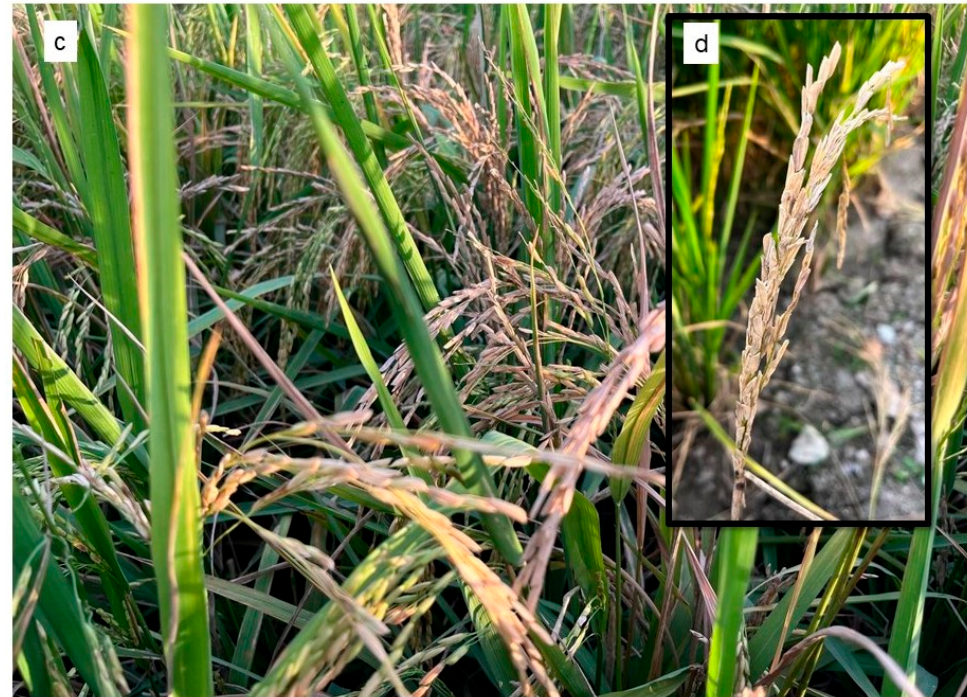
Figure 2. Excessive use of biocides and chemical fertilizers resulted in the severe outbreaks of various rice diseases in Selangor, Malaysia: ( a ) Rice plants infected by Pantoea spp. with a yellowish leaf blight disease lesion on the leaves that leads to unfilled, empty, and discolored grains (photo courtesy of Muhammad Nazri Ishak), ( b ) Close-up view of the infected leaf with a lesion at the edge (adapted from Doni et al. [16], the journal does not require permission to use materials), ( c ) Typical field symptoms of bacterial panicle blight caused by Burkholderia glumae with discoloration and sterility of grain as well as rotting and panicle blanking, ( d ) A close look at the severely infected panicle. The panicle remains upright rather than bending down with the weight of the grain (photo courtesy of Nurul Shamsinah Mohd Suhaimi). Therefore, the use of beneficial microorganisms for the biological control of plant diseases needs to be encouraged and promoted as a powerful solution to replace toxic chemical biocides.